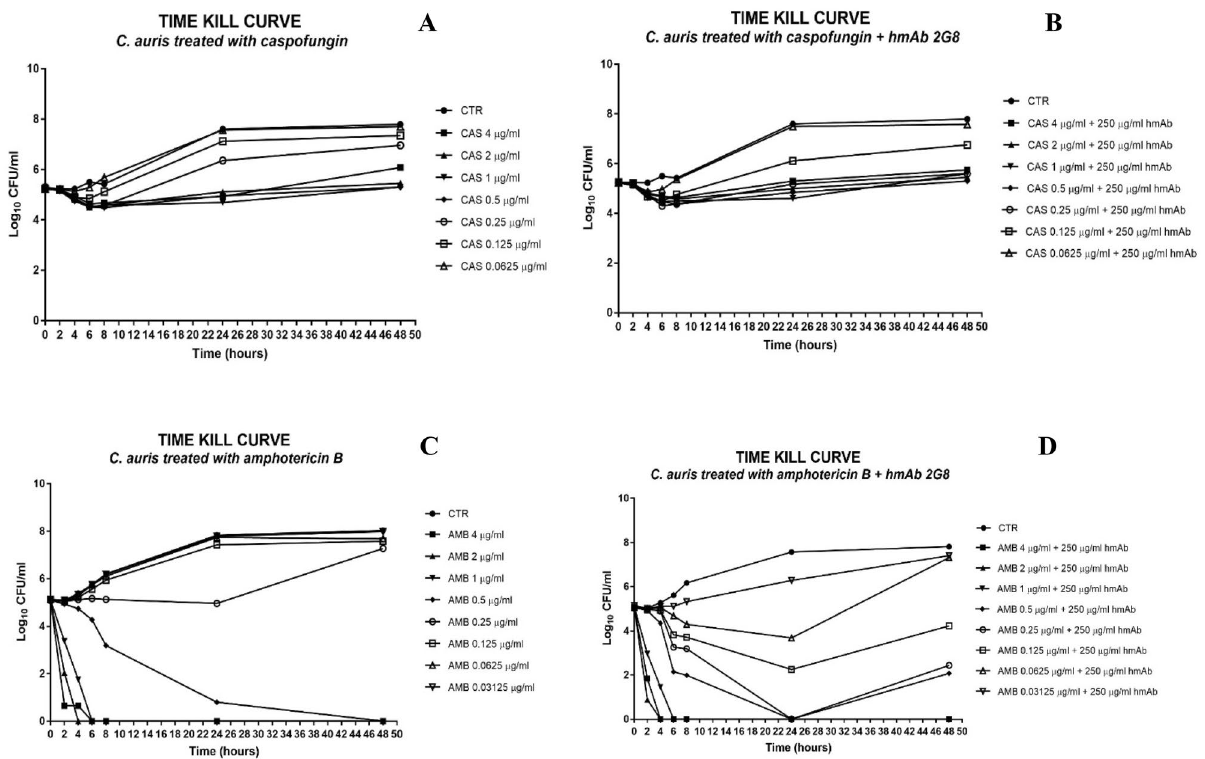
Figure 10. Time-kill curve of caspofungin ( A , B ) and amphotericin B ( C , D ) alone and in combination with H5K1.